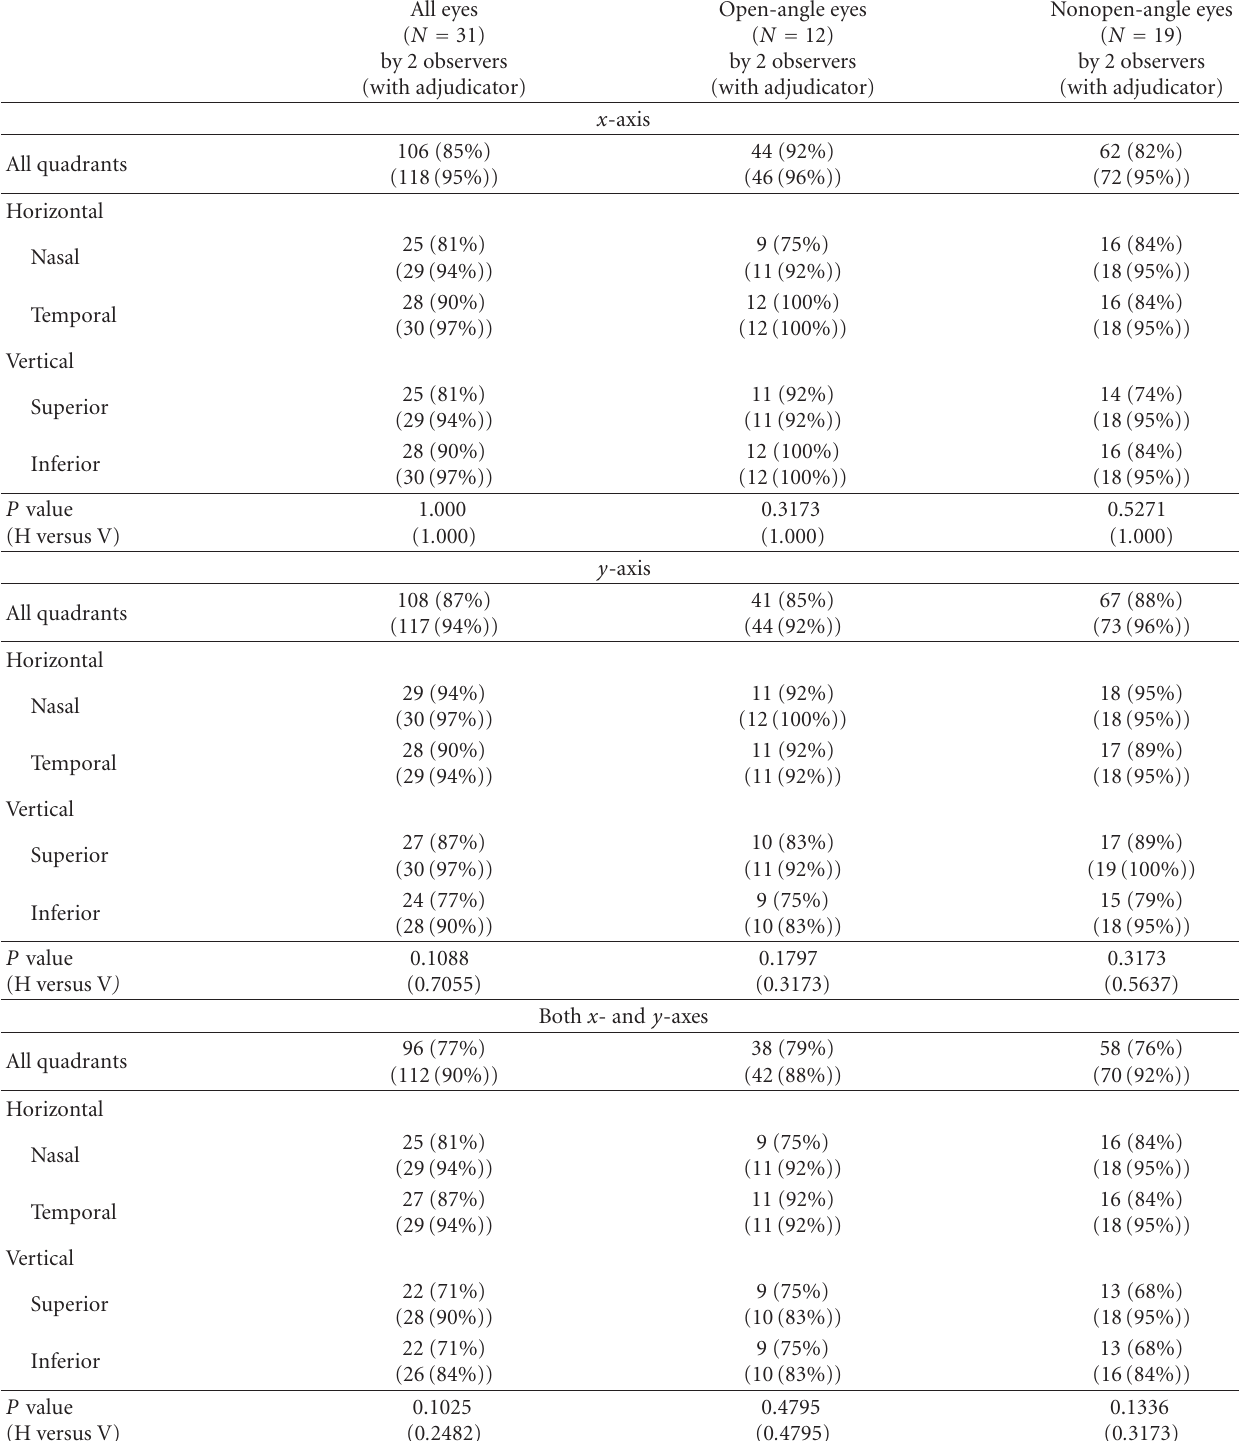
Table 1: Frequency (%) where scleral spur landmark identification was within 80 μ